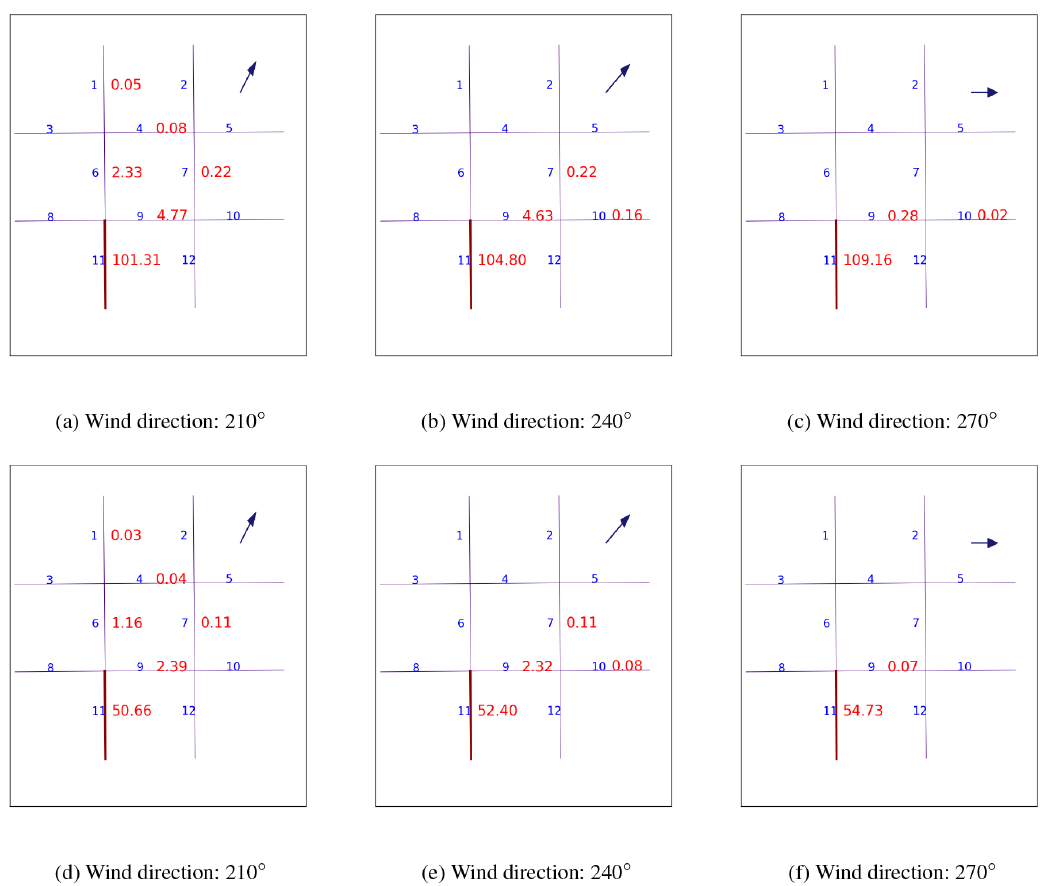
Figure 1. Variation of pollutant concentrations in a street network with wind direction, which are indicated as arrows in dark blue. The wind speed is 5ms − 1 for (a) , (b) , and (c) and 10ms − 1 for (d) , (e) and (f) . The wind direction is given from the north (top of the figure). The blue numbers are the street ID and the red numbers are the concentrations in µgm − 3 . A pollutant is only emitted in street segment